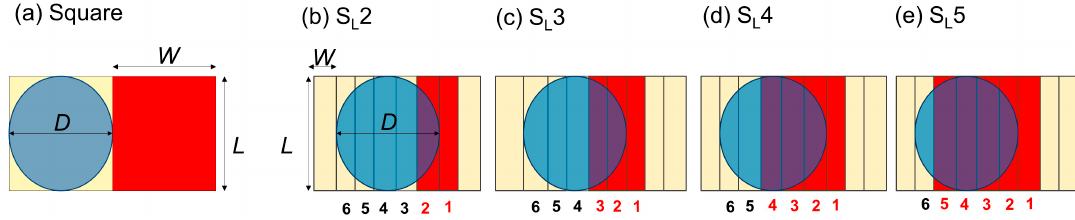
Figure 2. Schematic top view of: ( a ) Square electrode; ( b )–( e ) Slender electrodes with various electrode operation schemes. L , W and D denote electrode length, width and droplet diameter, respectively. Red areas represent the activated electrodes. The droplet moves from left to right in this figure.